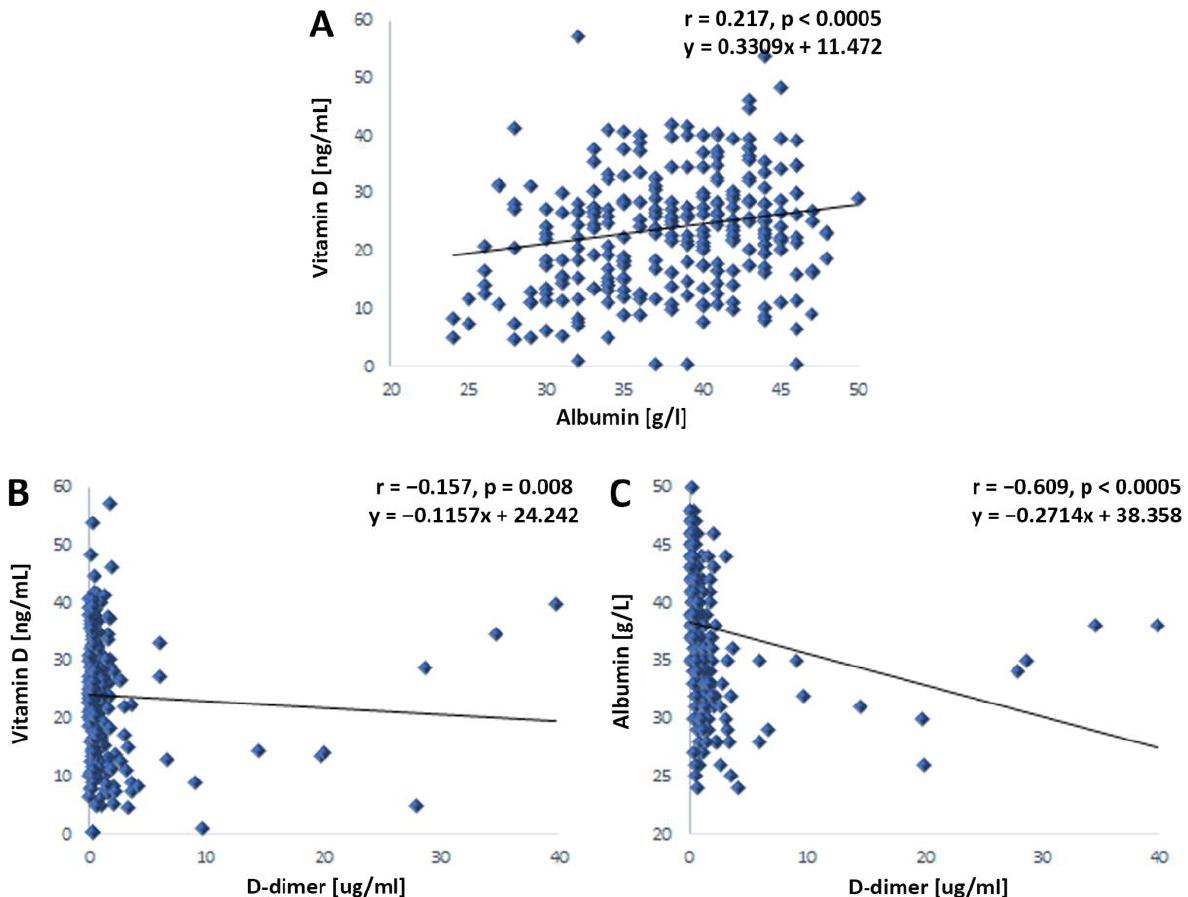
Figure 5. Intercorrelations of serum albumin, D-dimer, and vitamin D in patients with COVID-19. The serum values of the examined biochemical parameters were obtained from blood samples immediately after admission to the hospital for treatment (n = 288). ( A ) Correlation of albumin and vitamin D in patients with COVID-19. ( B ) Correlation of D-dimer and vitamin D in patients with COVID-19. ( C ) Correlation of D-dimer and albumin in patients with COVID-19. Statistical significance was examined using the Spearman correlation coefficient. Values of p < 0.05 were considered statistically significant.